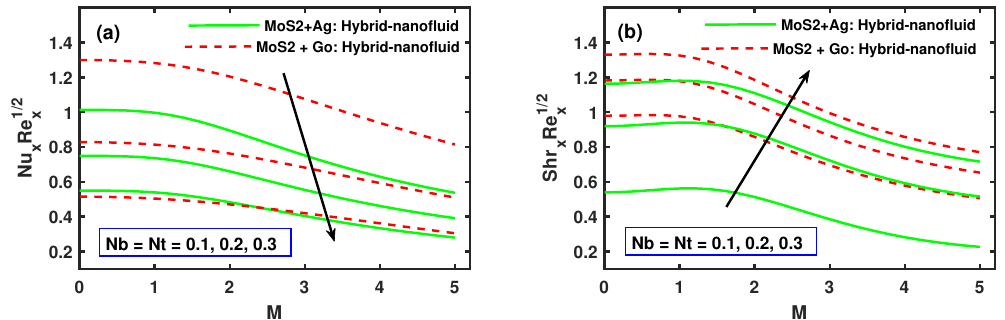
Figure 12. Fluctuation of Nu x Re 1/2 x and Sh x Re 1/2 x along with Nb, Nt (thermophoresis), and M (magnetic field).